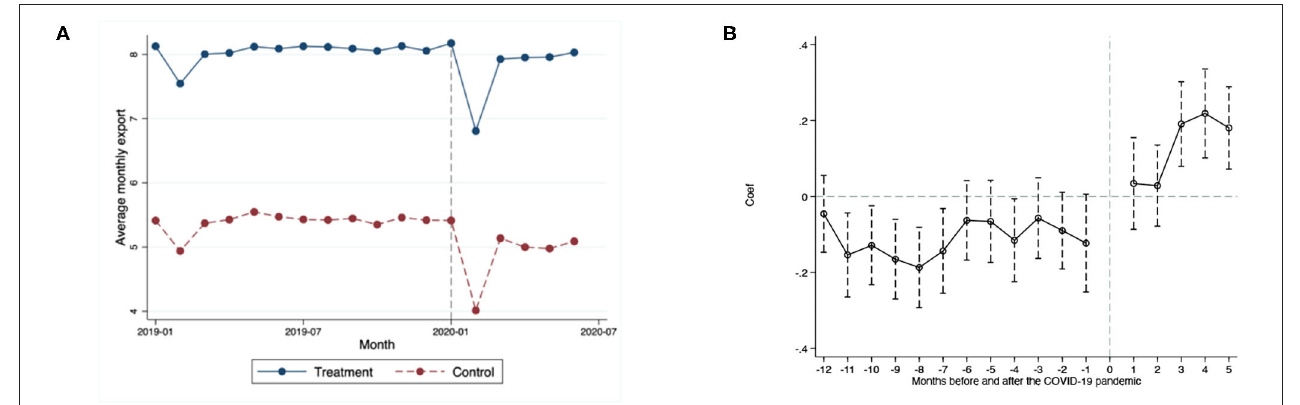
FIGURE 1 | Parallel trend test. (A) Time series plot. (B) Regression coefficients of the pandemic effect.